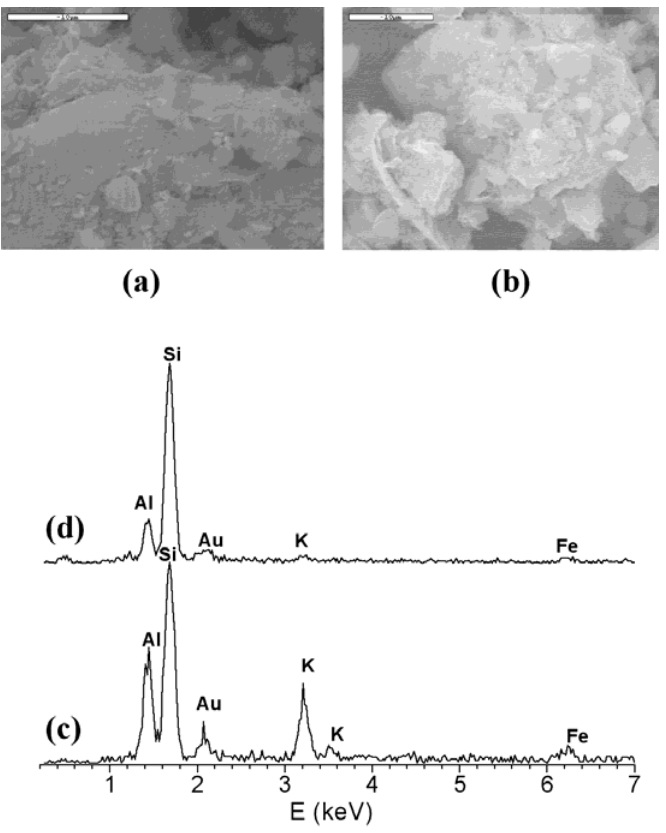
Figure 2. SEM microphotographs and EDX spectra of acid treated